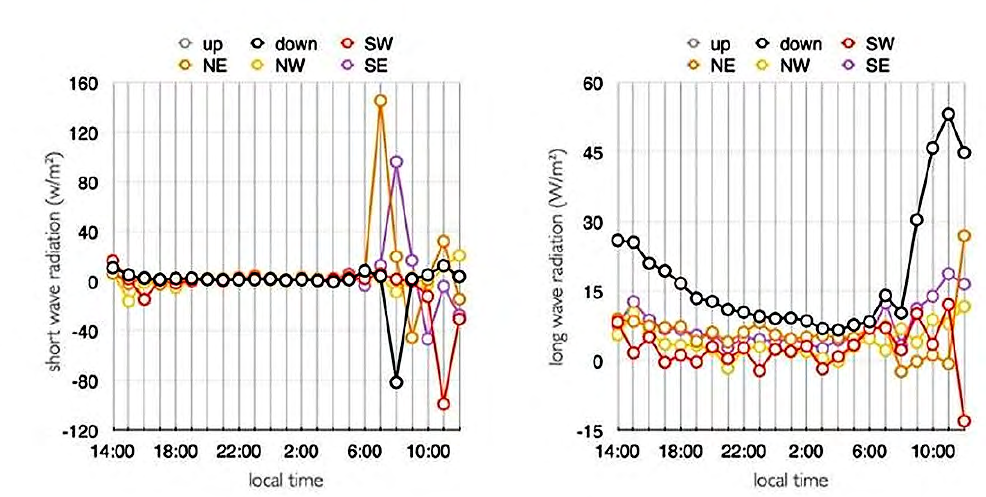
Figure 5. The difference of measured short-wave (ΔSw) and long-wave (ΔLw) radiation above the concrete ground relative to the